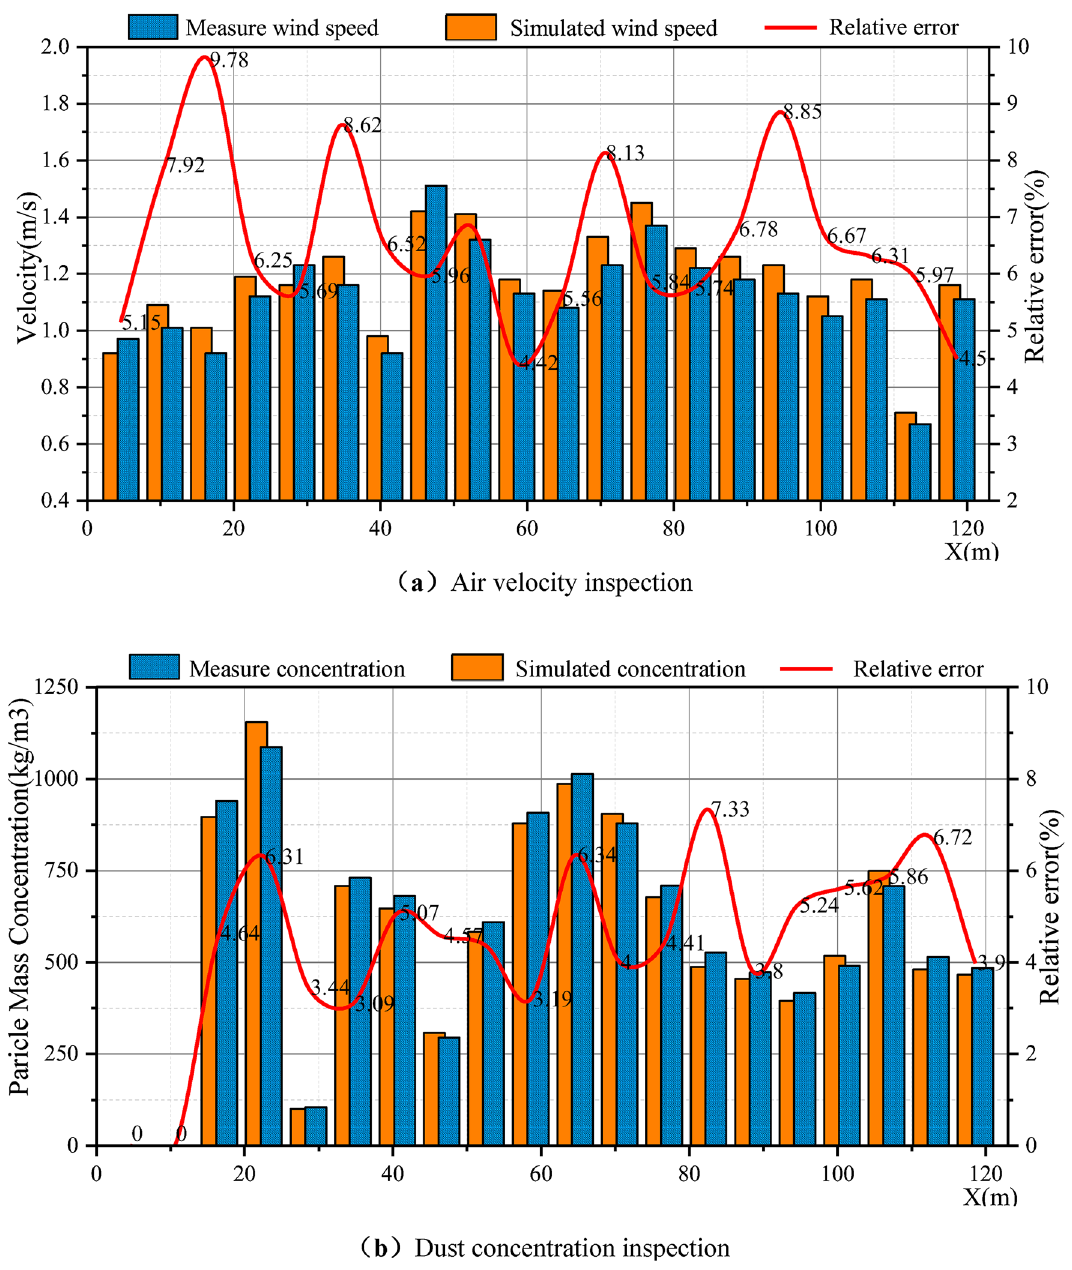
Figure 3. Comparison of numerical simulation and field measurement data of the fully mechanized mining face [( a ) Verification of air velocity; ( b ) verification of dust